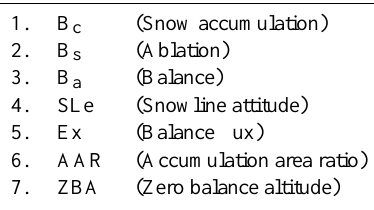
Table 1. PTAA model variables.